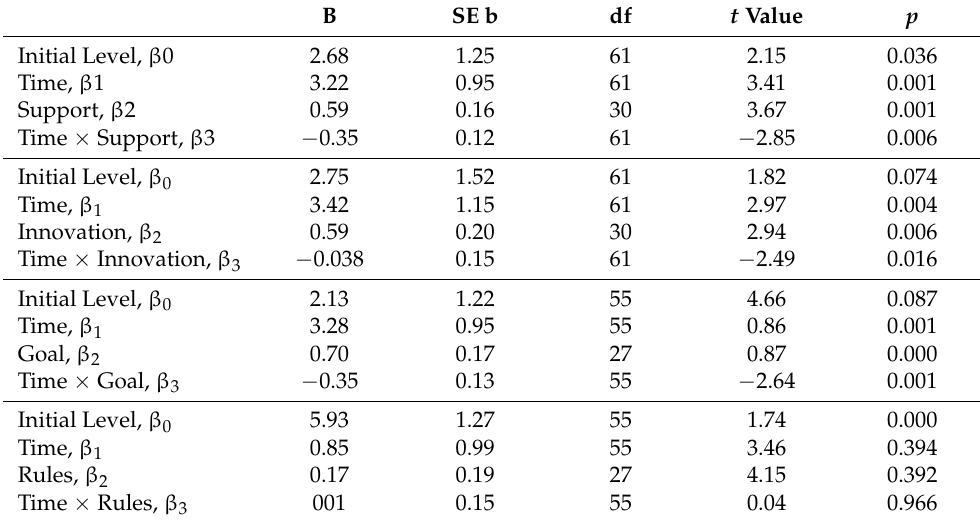
Table 2. Multilevel model for the interaction effect Time x Team culture orientations (support, innovation, goal, and rules) on experimenting. B SE